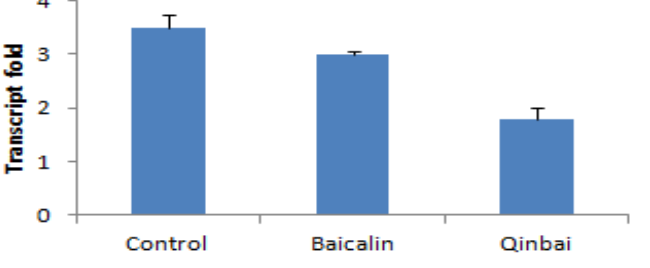
Figure 4. Expression of the P1 protein was assessed by immunoblot. Baicalin and Qinbai depressed P1 protein expression. Experiments were repeated twice. Data are presented as mean ± SD, p <